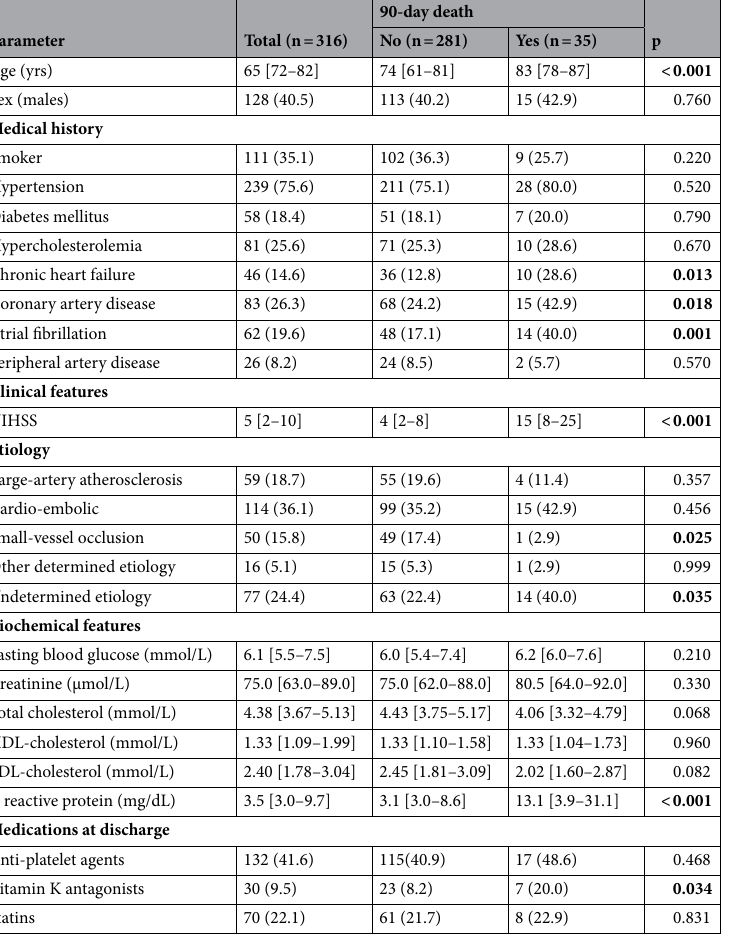
Table 1. Baseline characteristics at the time of enrolment in the overall population and after stratification for 90-day mortality. Data are presented as median [IQR] for continuous variables, and count (%) for categorical ones. Comparisons are performed through Mann–Whitney U test and Fisher exact test. Significant p-values are highlighted in bold. HDL: high-density lipoprotein; LDL: low-density lipoprotein, NIH: National Institute of Health Stroke Scale.